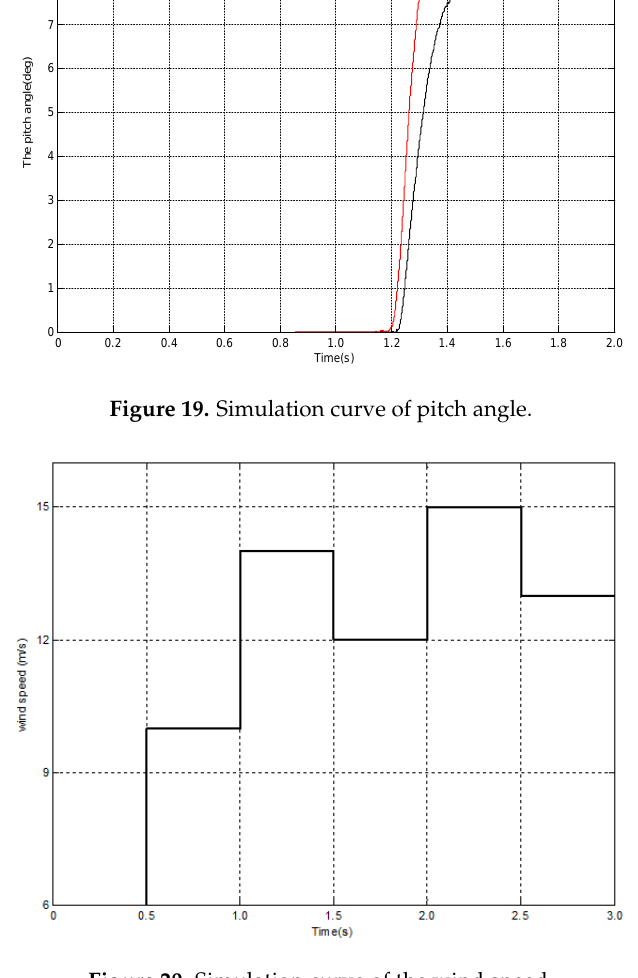
Figure 20. Simulation curve of the wind speed.